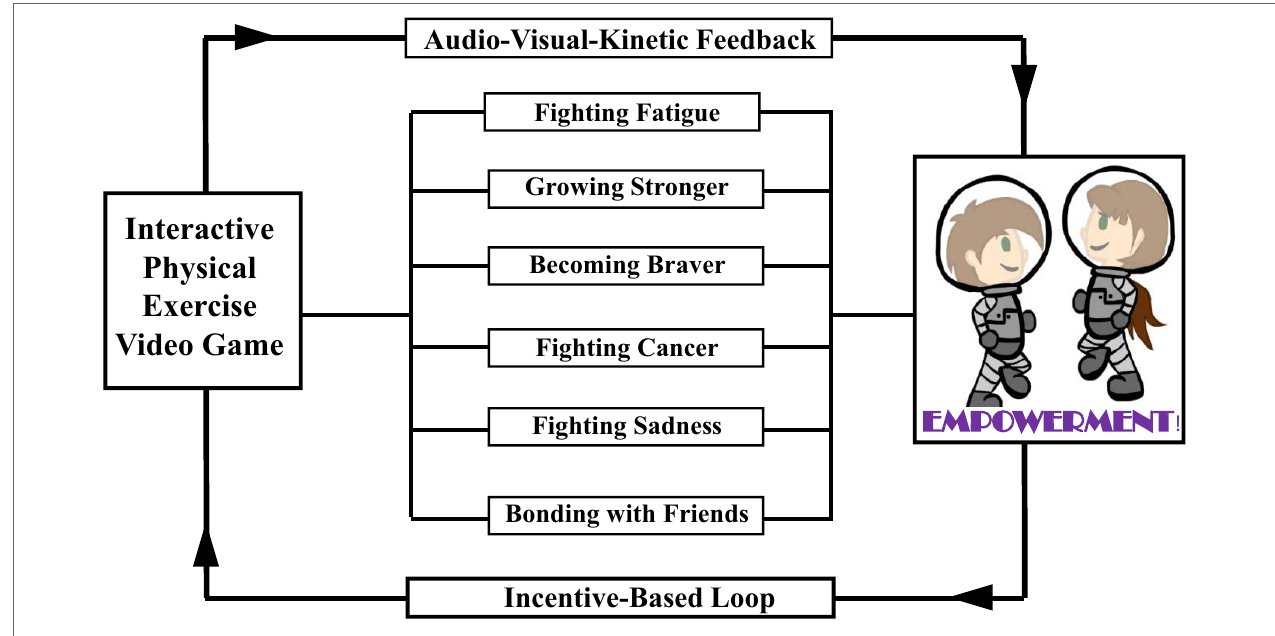
FigUre 3 | The prototype Empower Stars! video game is grounded in behavioral, empowerment, exercise, and engagement theories. It serves as a promising prototype intervention that couples exercise with empowerment over a specific disease to positively influencing health, disease, and therapy understanding in children with cancer and other chronic pediatric